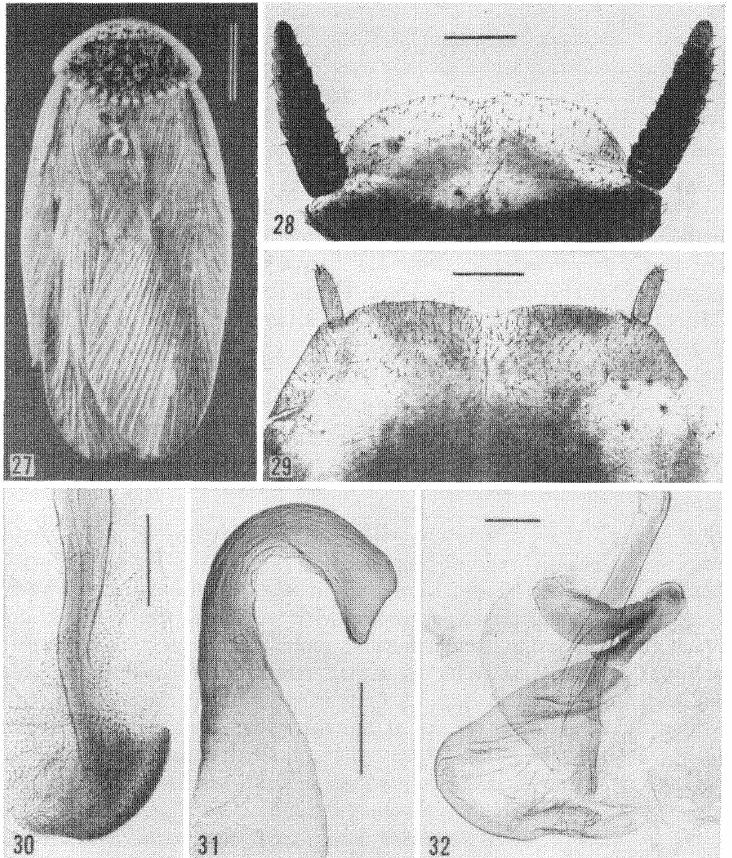
Figures 27-32. Calolampra #aula. 27-32. 6 (2 SAM), lectotype, Ardros- san, S. A. 27. Adult. 28-29. Supra-anal and subgenital plates. 30-32. Geni- talia (Fig. 32 is a ventral view). Scale: Fig. 27 mm; Figs. 28-29 0.5 ram; Figs. 30-32 0.2